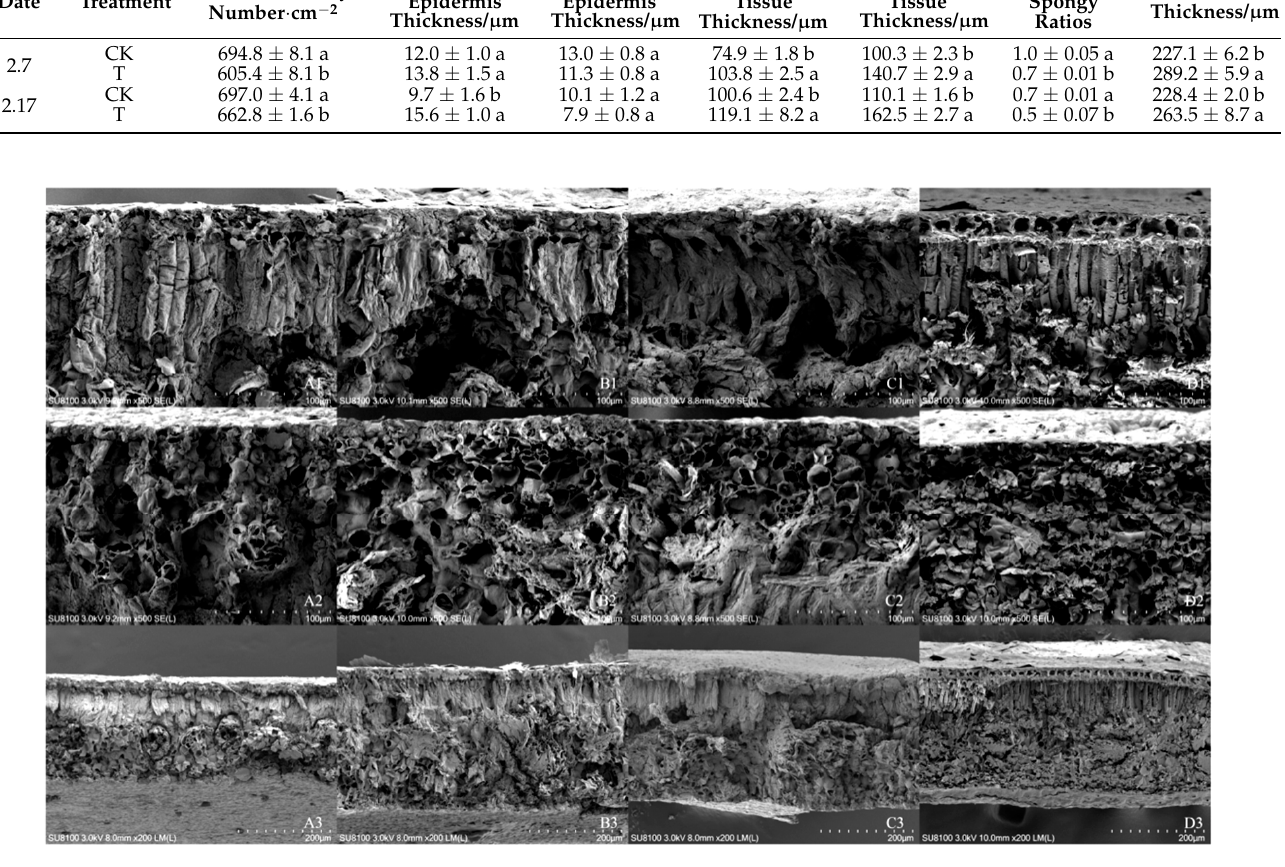
Table 3. The effect of enhanced UV − B radiation on the microstructure of mesophyll cells in leaves.